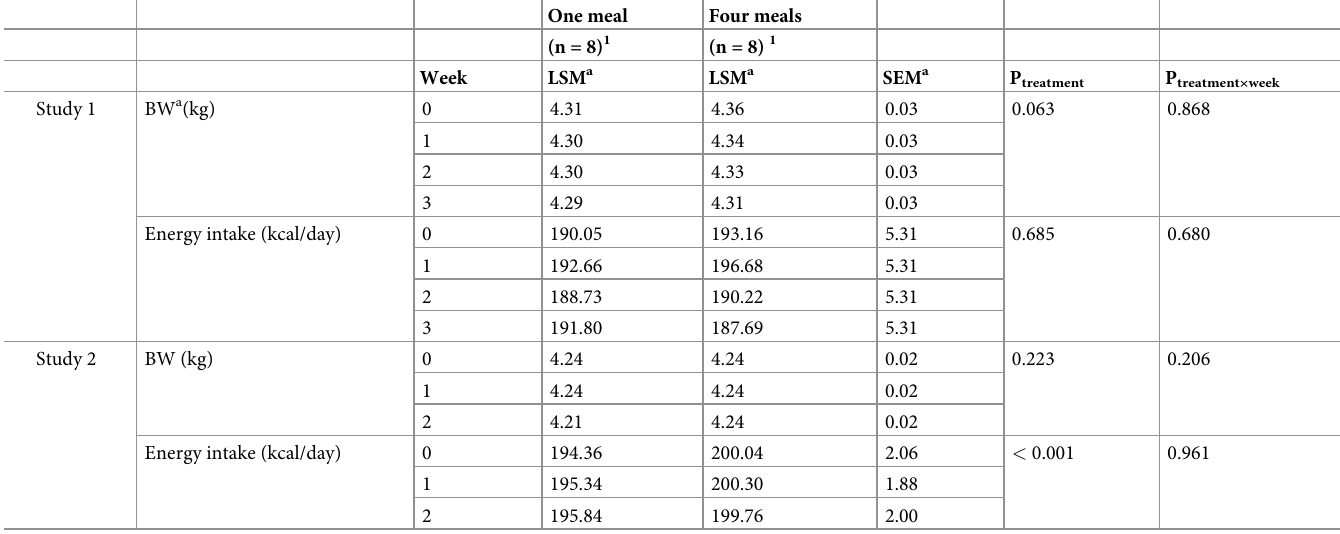
Table 2. Body weight (kg) at baseline and weekly throughout Study 1 and Study 2 and energy intake (kcal/day) at baseline and weekly throughout Study 1 and Study 2 in cats eating a canned diet once (0800 h) or four (0800 h, 1130 h, 1500 h, 1830 h) times daily.